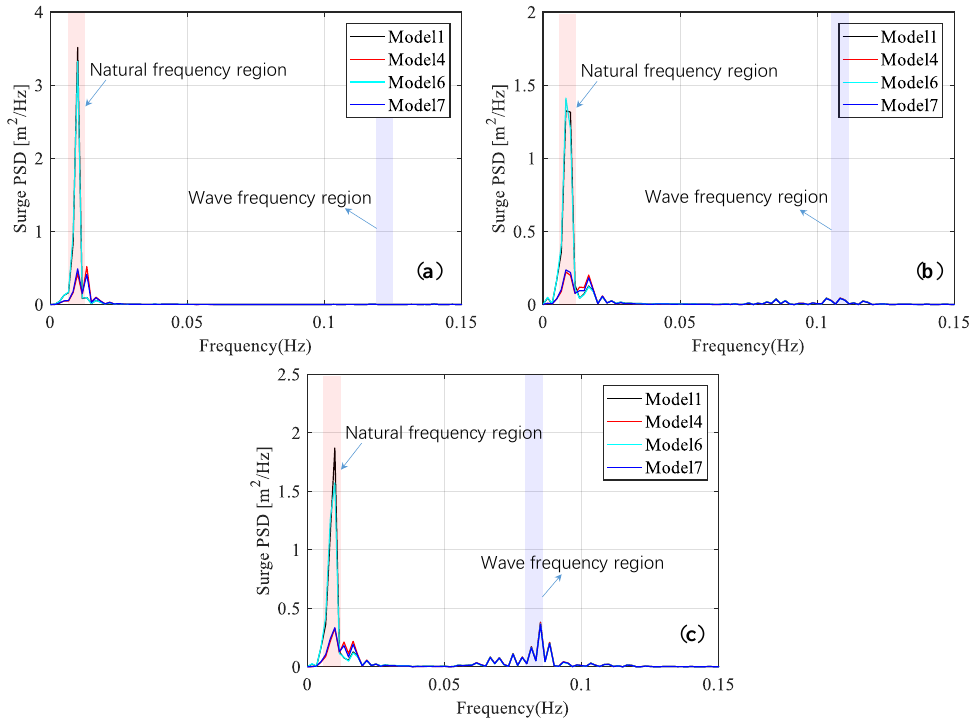
Figure 24. Comparison of the surge motion of Model 1, 4, 6, and 7 in the frequency domain: ( a ) LC4; ( b ) LC5; and ( c ) LC6.